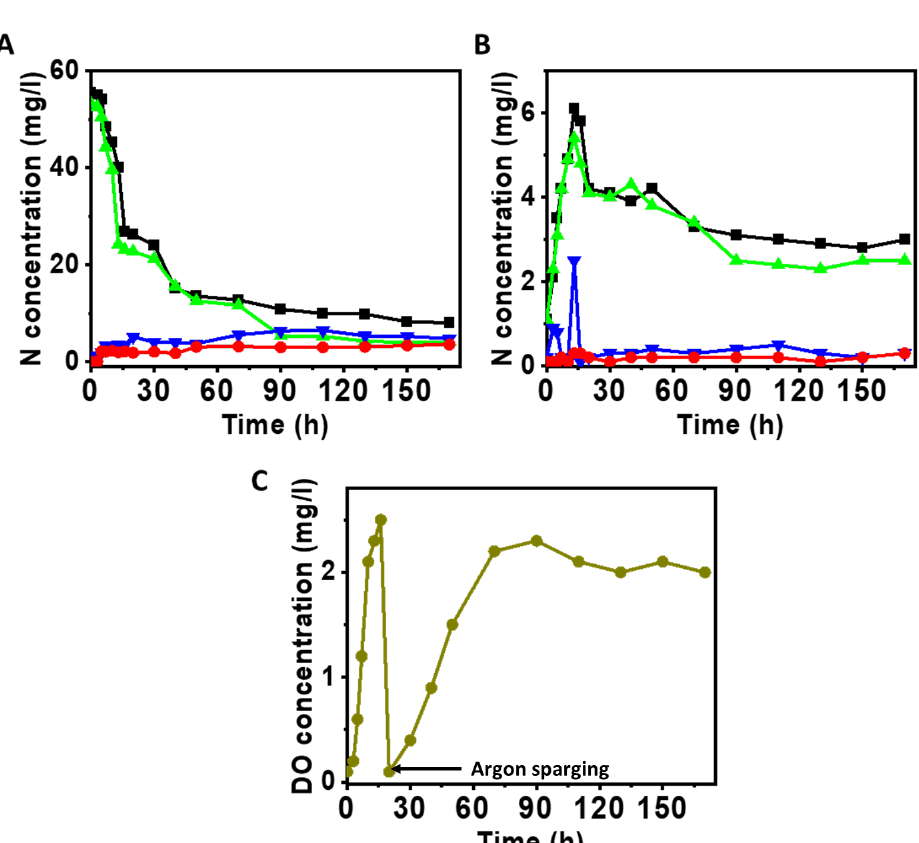
Figure 6. The denitrification at the cathode with an applied voltage of 1.5V and the nitrified solution from the anode. The reduction of nitrate-nitrogen and variation in other nitrogen — containing ions at cathode ( A ). The diffusion of nitrogen -containing ions from cathode to anode ( B ). The diffusion of DO was noted from anode to cathode (( C ); nitrogen sparging at 20 h). The black, green, blue, and red lines represent total N, NO 3 -N, NO 2 -N, NH 4 -N, respectively.